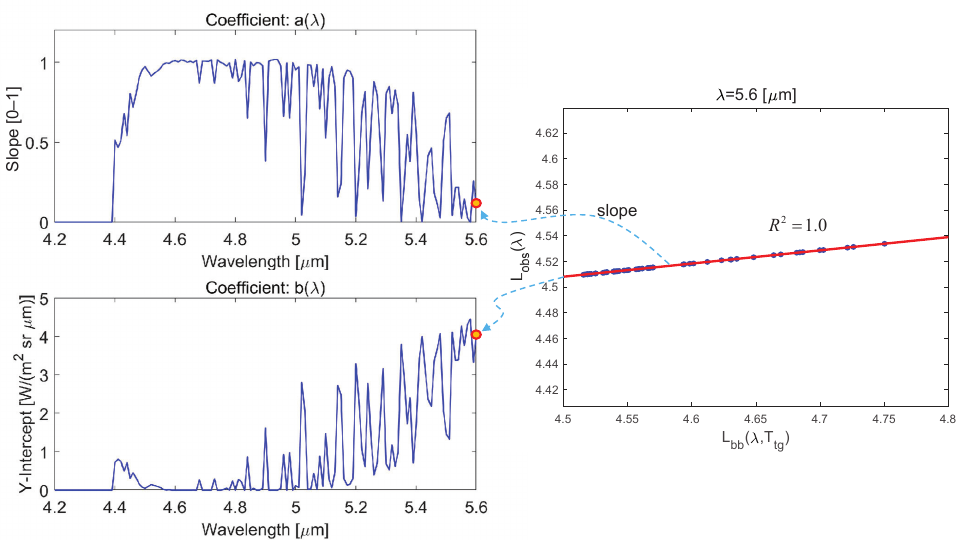
Figure 16. Data regression from synthetic spectra: ( left ) slope coefficient and y-intercept coefficient, and ( right ) data regression example for the 5.6 µ m